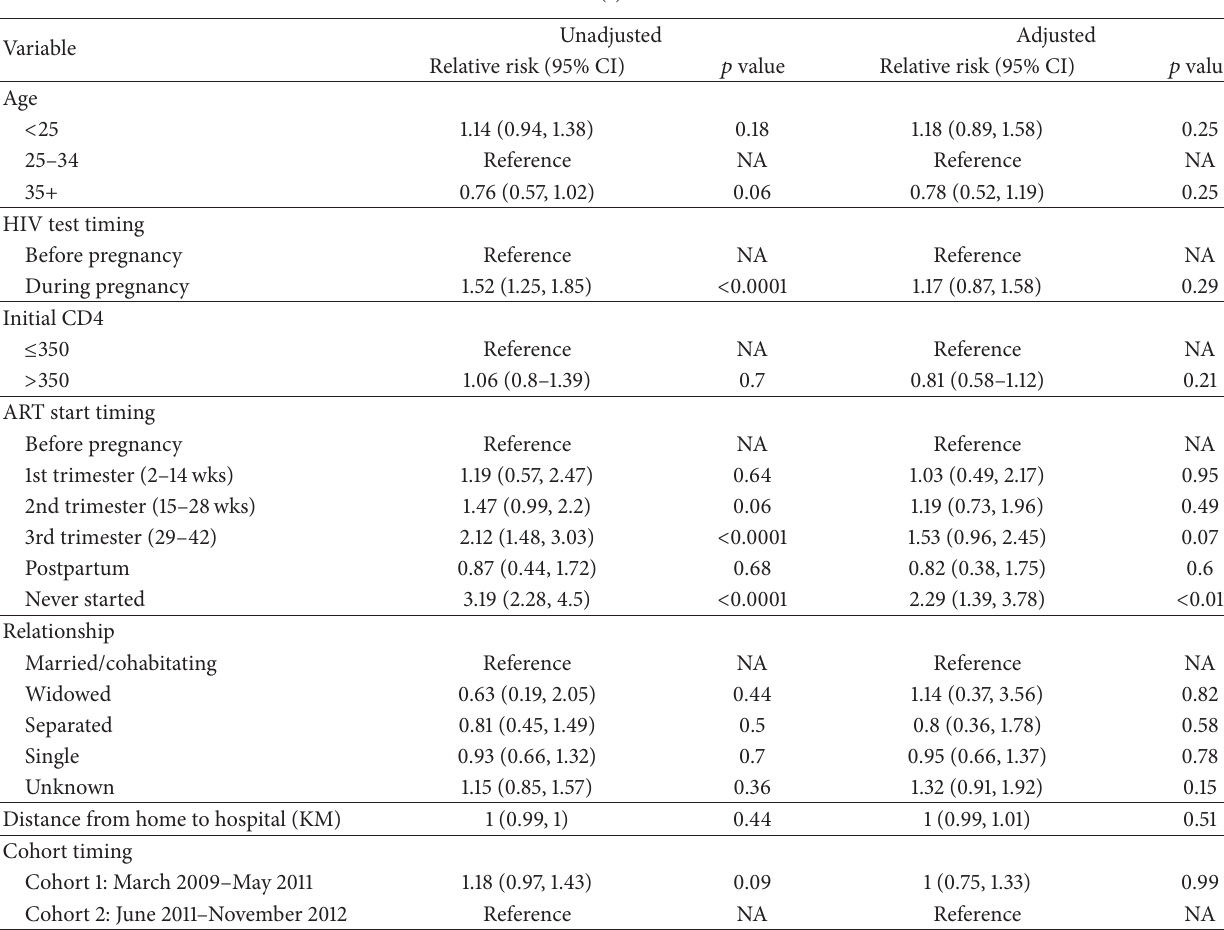
Table 3: (a) Risk factors for loss to follow-up: univariate and multivariate analysis ( 𝑛 = 463 ) ∗ . (b) Risk factors for loss to follow-up: univariate and multivariate subset analysis of women with 2 or more antenatal visits ( 𝑛 = 358 ) ∗